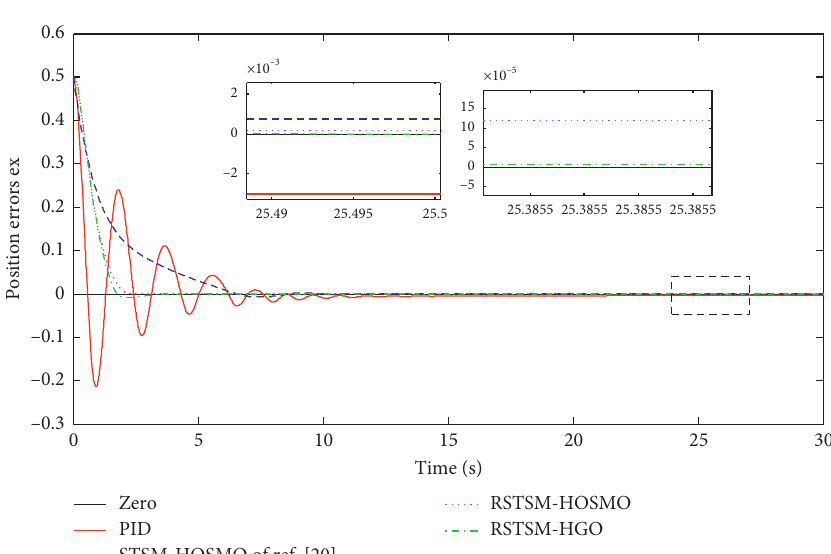
Figure 6: Trajectory tracking